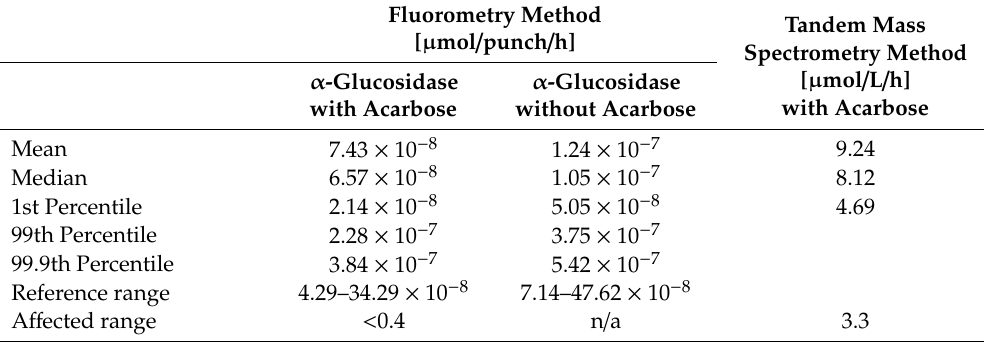
Table 3. Statistical results for both reference methods used in Hamburg (fluorometry) and Vienna (MS). For the normal values all specimens from individuals considered una ff ected by Pompe disease have been